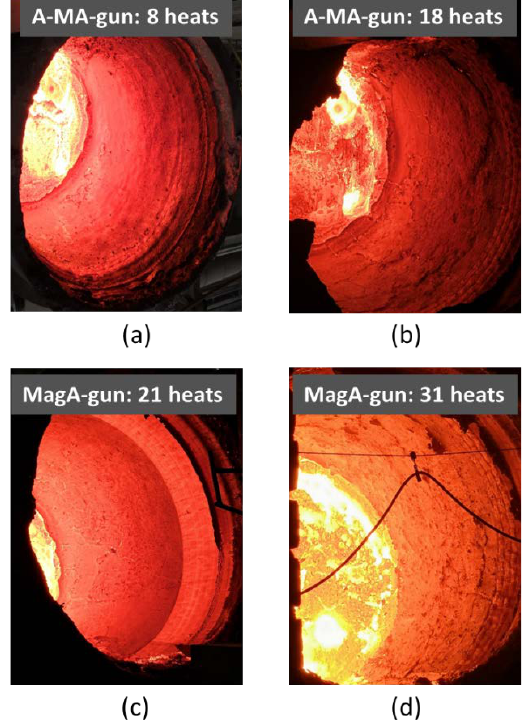
Figure 6. Steel ladles repaired with an A-MA-gun after eight heats in operation ( a ) and 18 heats ( b ) versus MagA-gun after 21 ( c ) and 31 heats ( d ).